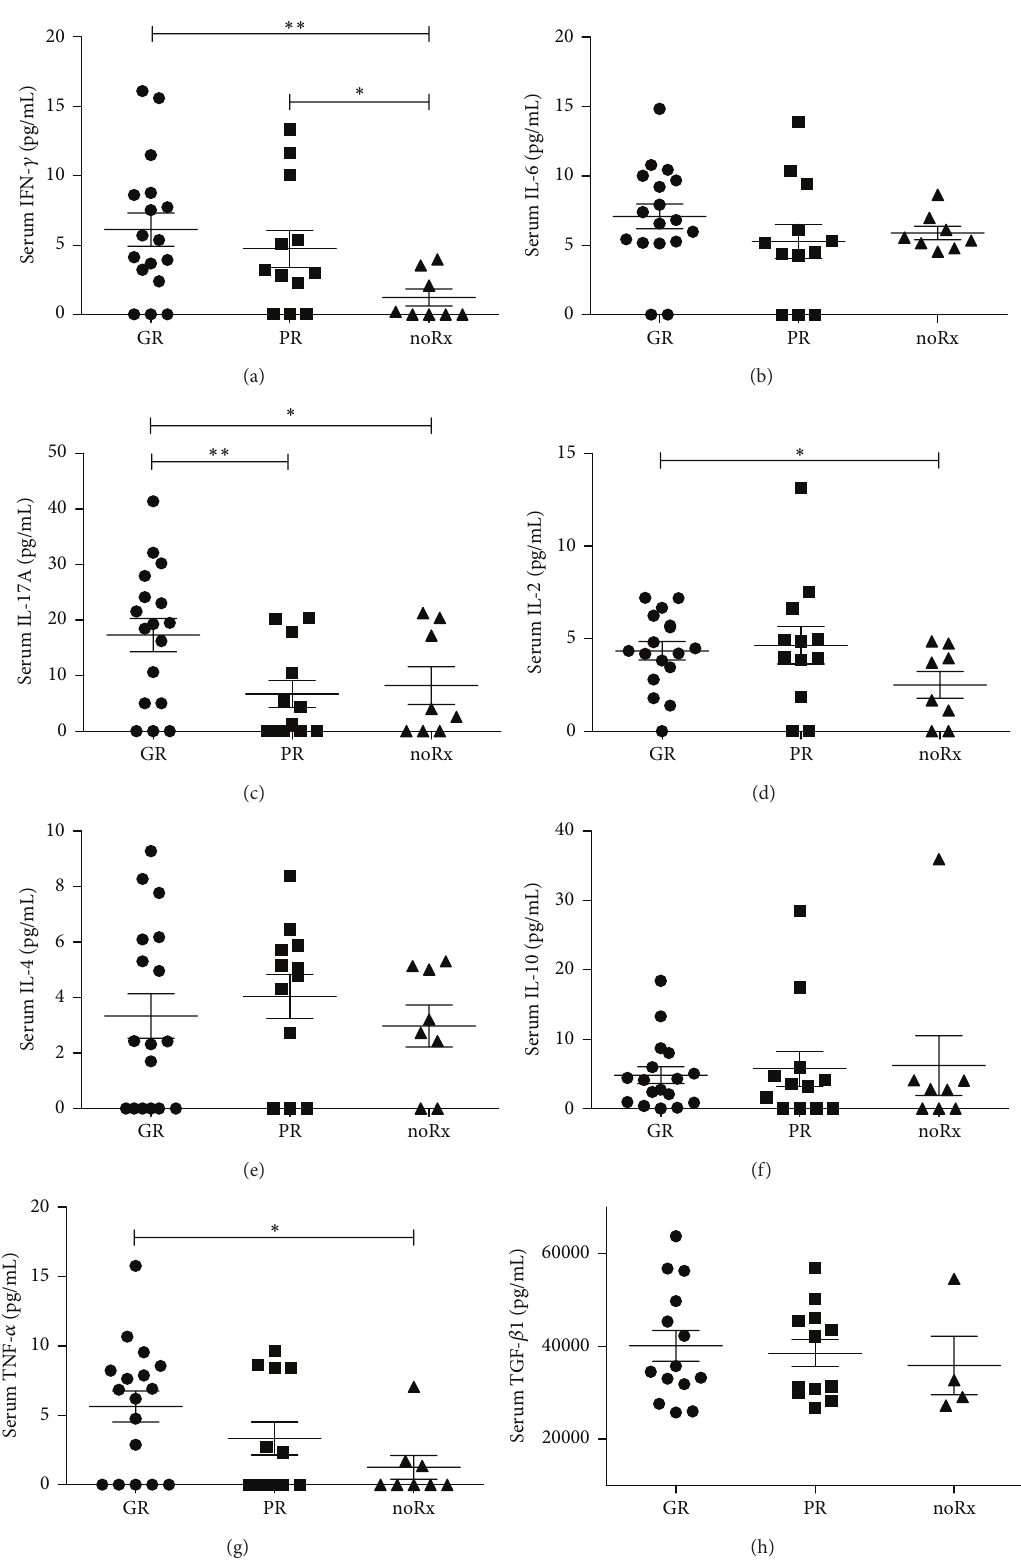
Figure 1: Serum cytokines in GR, PR, and noRx patients. (a) IFN- 𝛾 , (b) IL-6, (c) IL-17A, (d) IL-2, (e) IL-4, (f) IL-10, (g) TNF- 𝛼 , and (h) TGF- 𝛽 1. ∗ 𝑃 = 0.05 , ∗∗ 𝑃 = 0.03